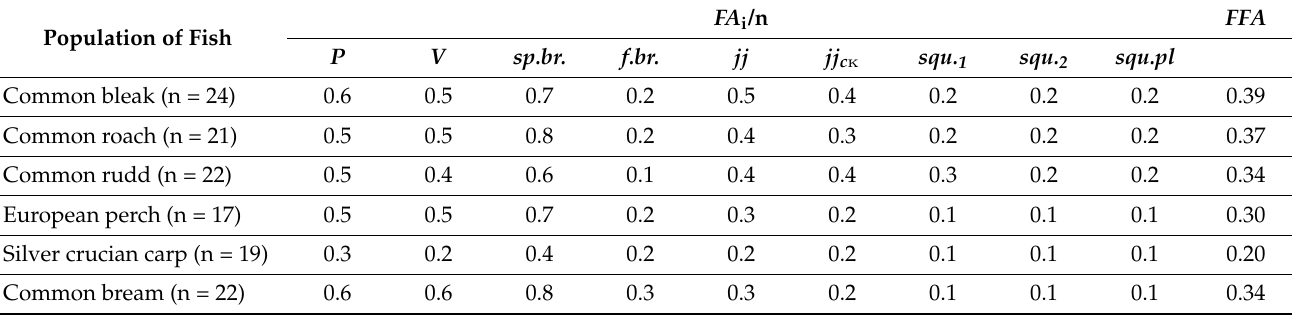
Table 8. The FFA for each studied fish population in the River Styr at sampling site No. 6 ( p ≤